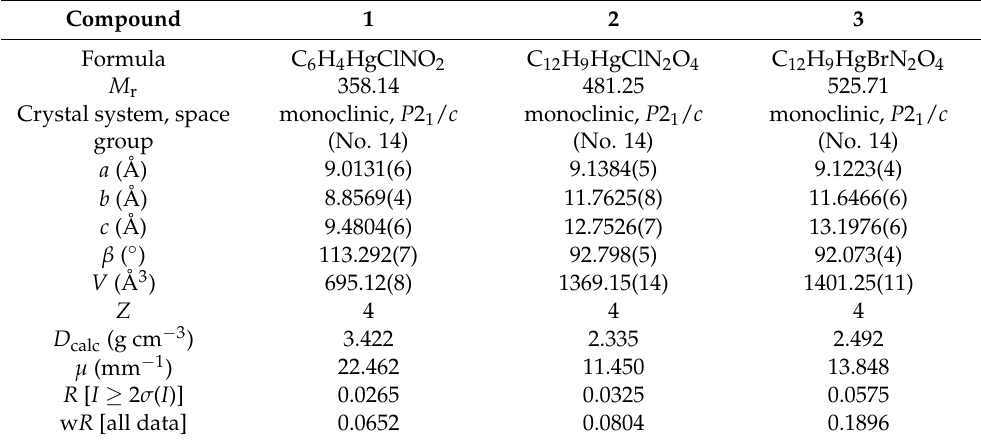
Table 2. Crystallographic data for {[HgCl(pic)]} n ( 1 ), [HgCl(pic)(picH)] ( 2 ) and [HgBr(pic)(picH)] ( 3 ).